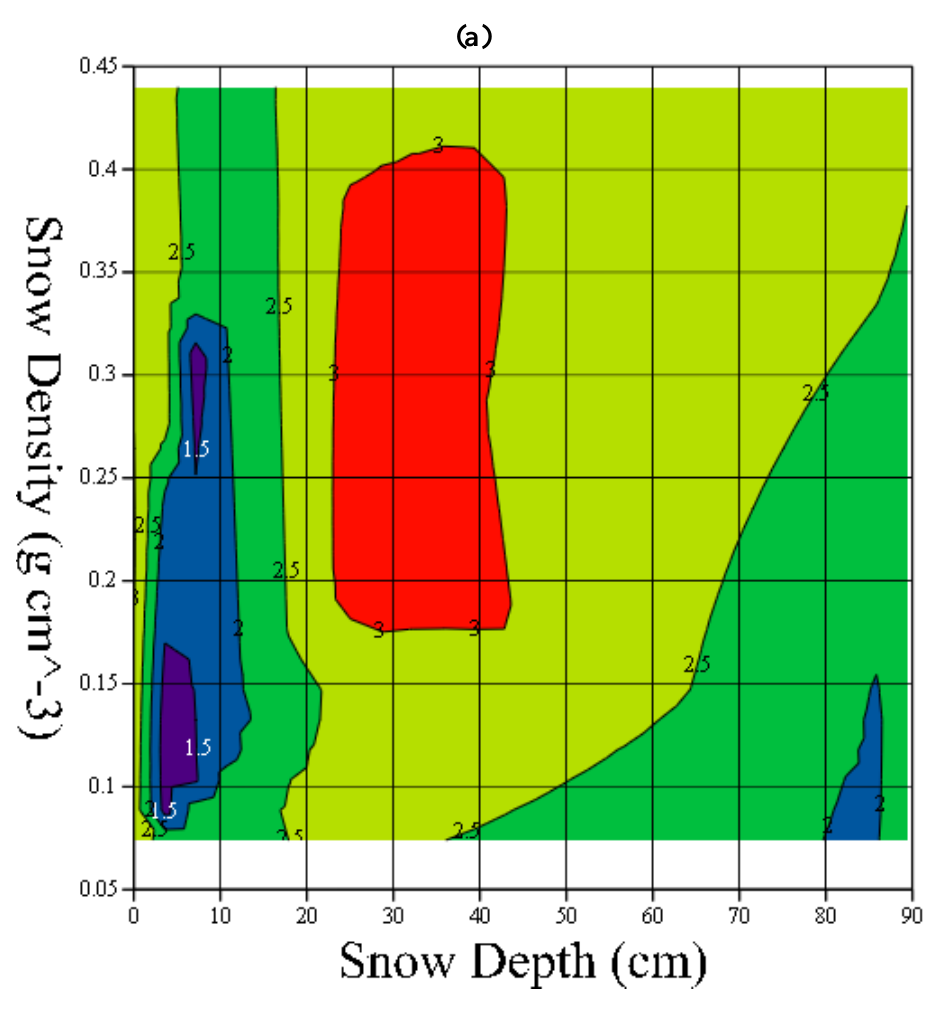
Figure 3. (a) Two-dimensional contour plot of snow depth ( t ) and snow density ( ρ contour values of standard error (SE) of the QNA output values produced by the 45 input pair combinations of snow depth and permittivity (ε algorithm (QNA). The purple regions show the smallest SE. (b) Expanded view of (a) for output snow depths between 0 and 10